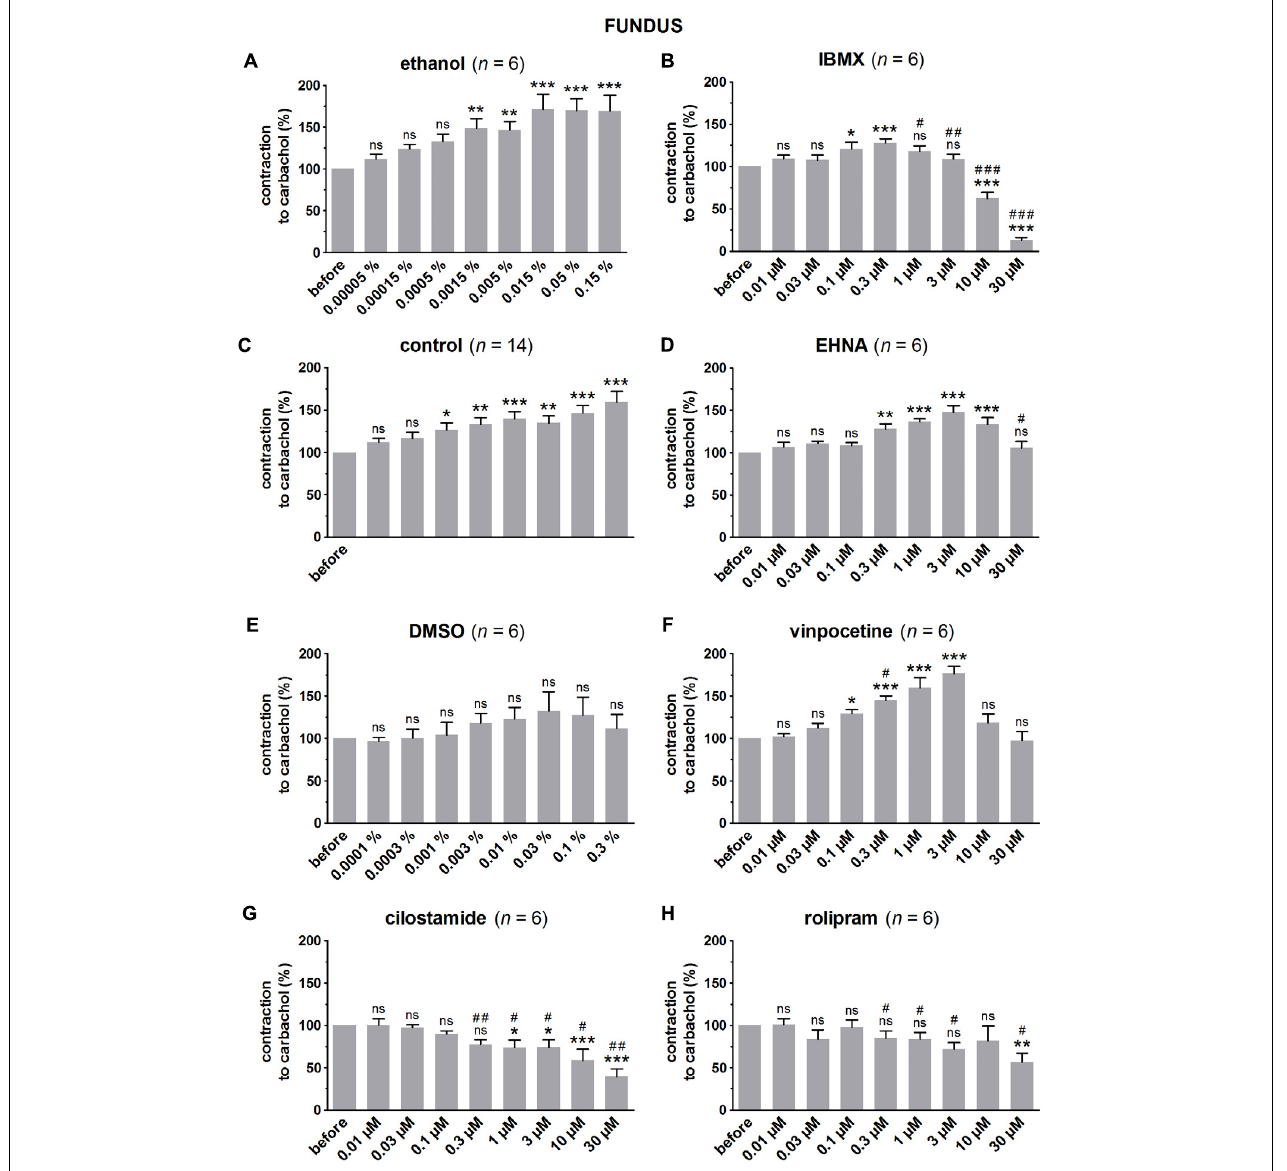
FIGURE 1 | Influence of increasing concentrations (0.01–30 µ M) of the PDE inhibitors IBMX (B) , EHNA (D) , vinpocetine (F) , cilostamide (G) and rolipram (H) , and the solvents ethanol (A) and DMSO (E) on submaximal carbachol-induced contractions (0.04 µ M) in murine fundus circular smooth muscle strips. Parallel time controls not receiving PDE inhibitor or solvent are shown in (C) . Contractions in the presence of increasing concentrations of the PDE inhibitor are expressed as percentage of the reference contraction before addition of the PDE inhibitor. Means ± SEM; ns not significant, ∗ P < 0.05, ∗∗ P < 0.01, ∗∗∗ P < 0.001 versus reference before (repeated measures ANOVA with Bonferroni corrected t -test) and # P < 0.05, ## P < 0.01, ### P < 0.001 versus corresponding control (unpaired t